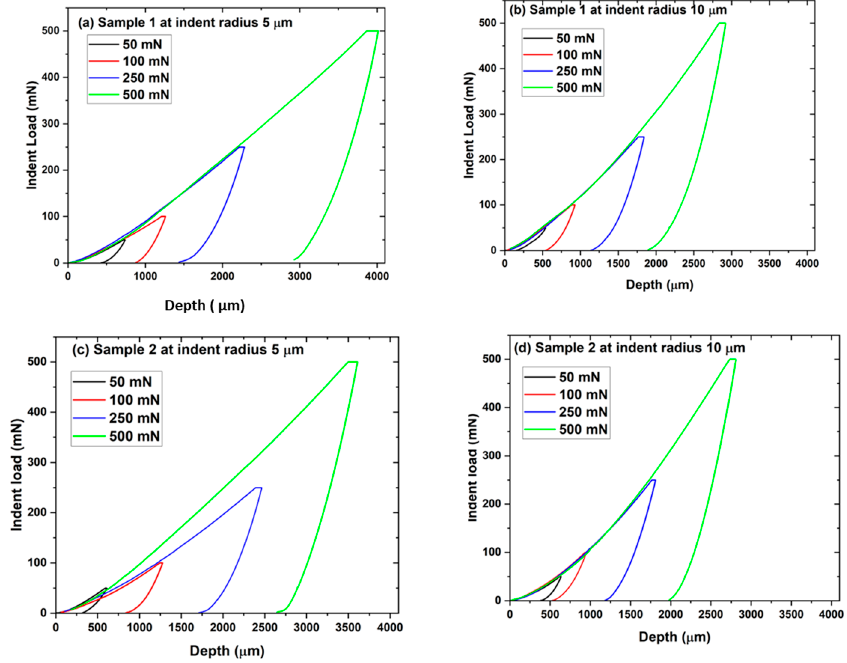
Figure 7. ( a – d ) Load-depth curves of selected indentations using various loads and different radii of 5 and 10 µm.